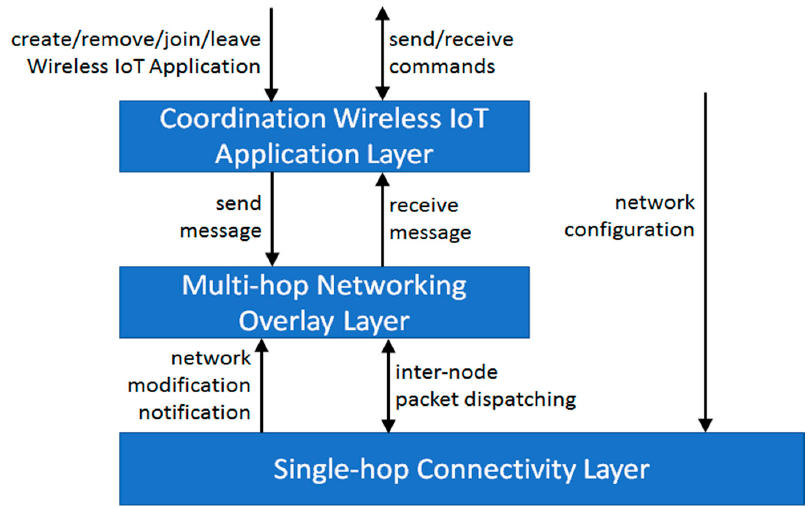
Figure 1. High-level overview of the three-layer reference architecture.